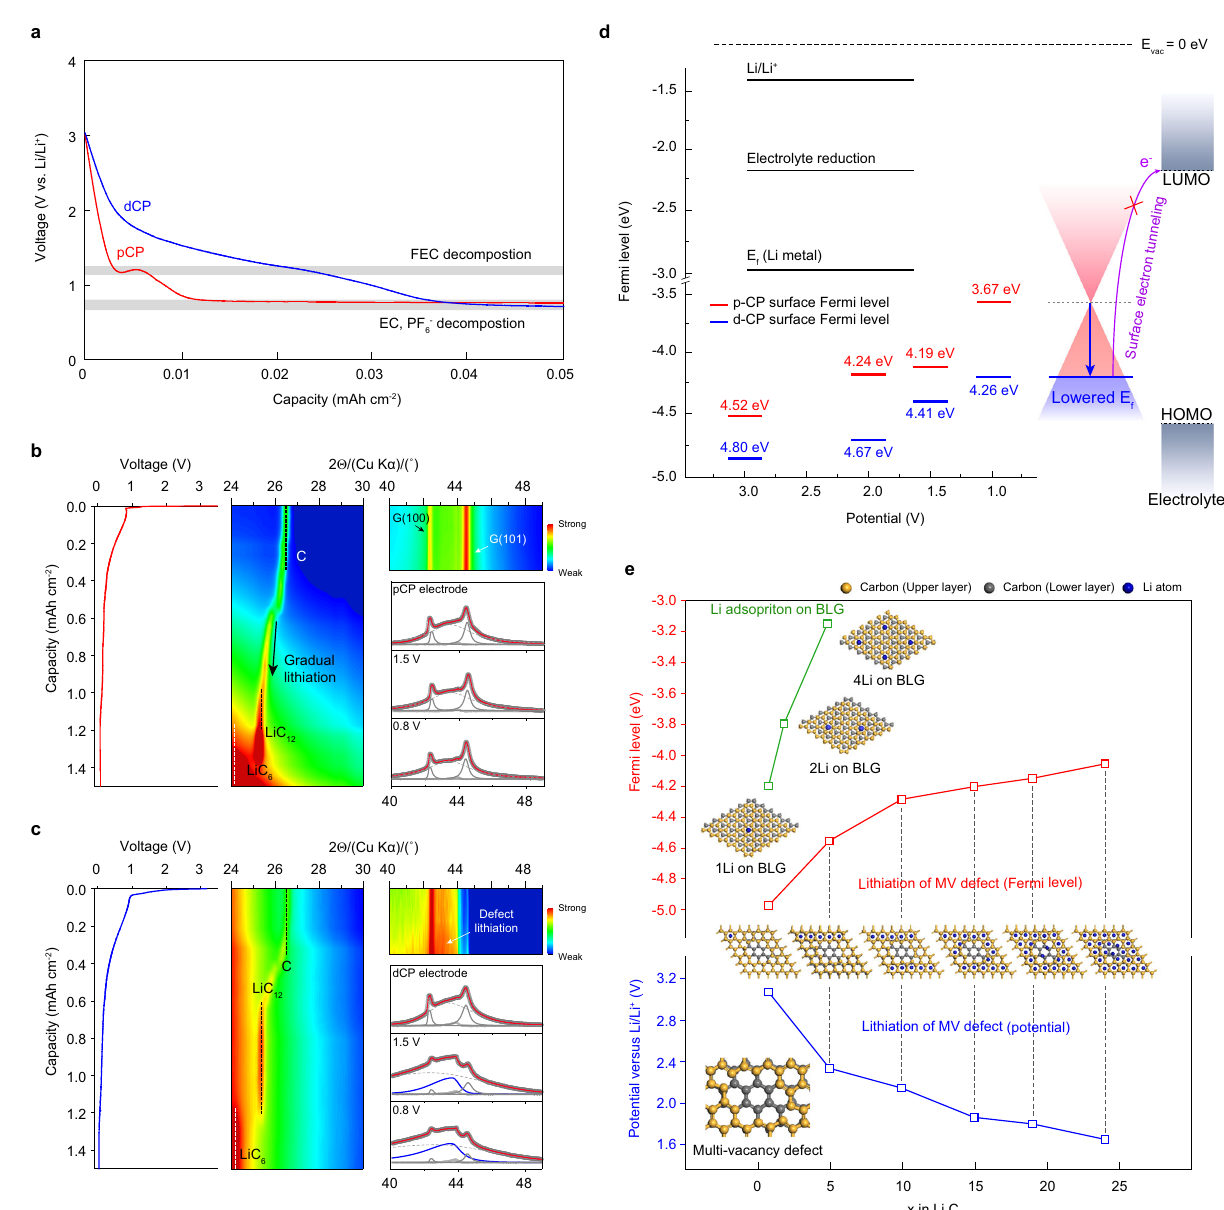
Fig. 4 Atomistic and electronic structure of multivacancy defects during lithiation. a Voltage pro fi les for the early stage of galvanostatic lithiation for p-CP and d-CP at 0.1 mA cm − 2 in the half-cell con fi guration. b , c Image plots of operando-XRD spectra along with the potential pro fi le during the fi rst lithiation and deconvoluted XRD patterns at the OCV, 1.5 V and 0.8 V for p-CP ( b ) and d-CP ( c ). The peaks from the lithiated defect structure (Li 3 C 8 ) at 2 θ of 43° are indicated by blue lines. d Plots of the Fermi levels of p-CP and d-CP during lithiation from the OCV to 1.0 V (V vs. Li/Li + ), as determined from extrapolation of the secondary cutoff region in UPS. All the Fermi levels of Li/Li + , redox associated with electrolyte reduction, Li metal, p-CP, and d-CP were calibrated at a vacuum state of E vac = 0 eV. e Relaxed structures of lithiated BLG, MV, and fully lithiated MV (Li 3 C 8 ), corresponding DFT calculations of the Fermi level, and redox potential of MV at various lithiation degrees. The Li, carbon in the upper layer, and carbon in the lower layer are shown in blue, yellow, and gray colors, understood. The electron insulating property of the SEI depends on the SEI layer thickness ( d ) and Fermi level ( E Eq. (1) 23 : where T is the electron tunneling probability for complete electron insulation (namely, T ¼ e (cid:2) 40 ), 14,23 E